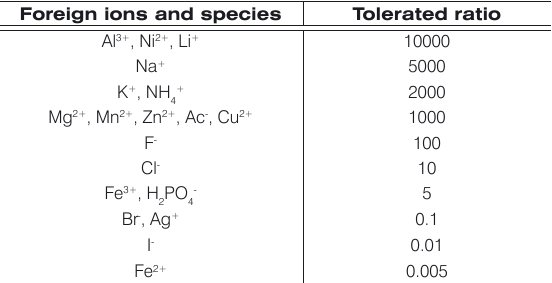
Table1. Influence of foreign ions and species on the determination of 5×10 -6 M Alizarin Red S. Foreign ions and